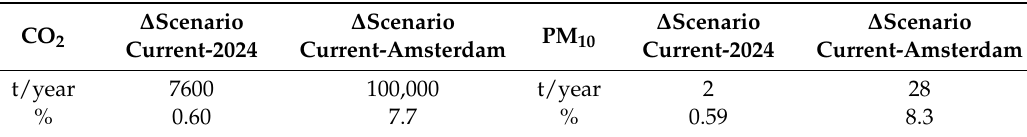
Table 6. Reduction in CO 2 and PM 10 emissions due to the increase in the number of cyclists assumed by the 2024 and Amsterdam scenarios compared to the current situation (trip distance of 7 km) and percentage of traffic emissions reduction in